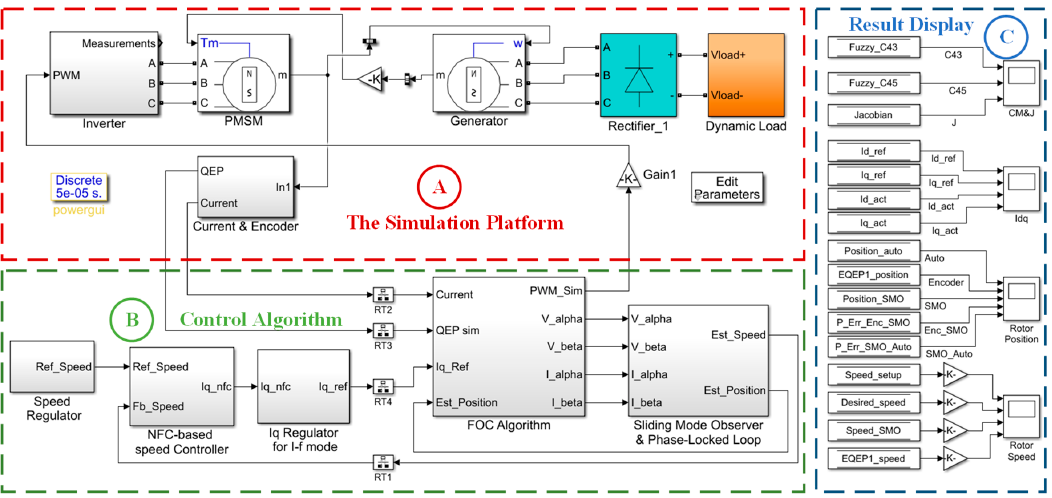
Table 1. The initial fuzzy rule table of fuzzy logic controller (FLC).